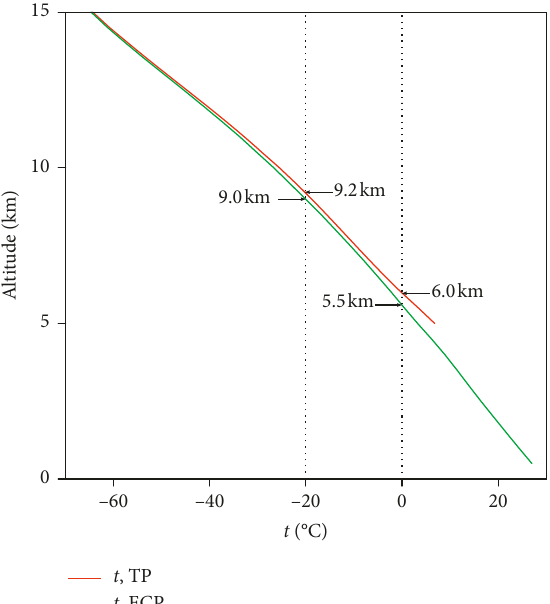
Figure 5: Vertical profiles of temperature.